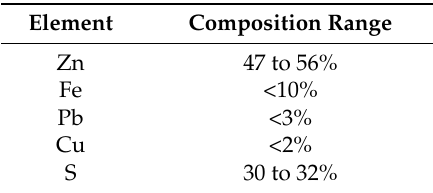
Table 1. Metallurgical target